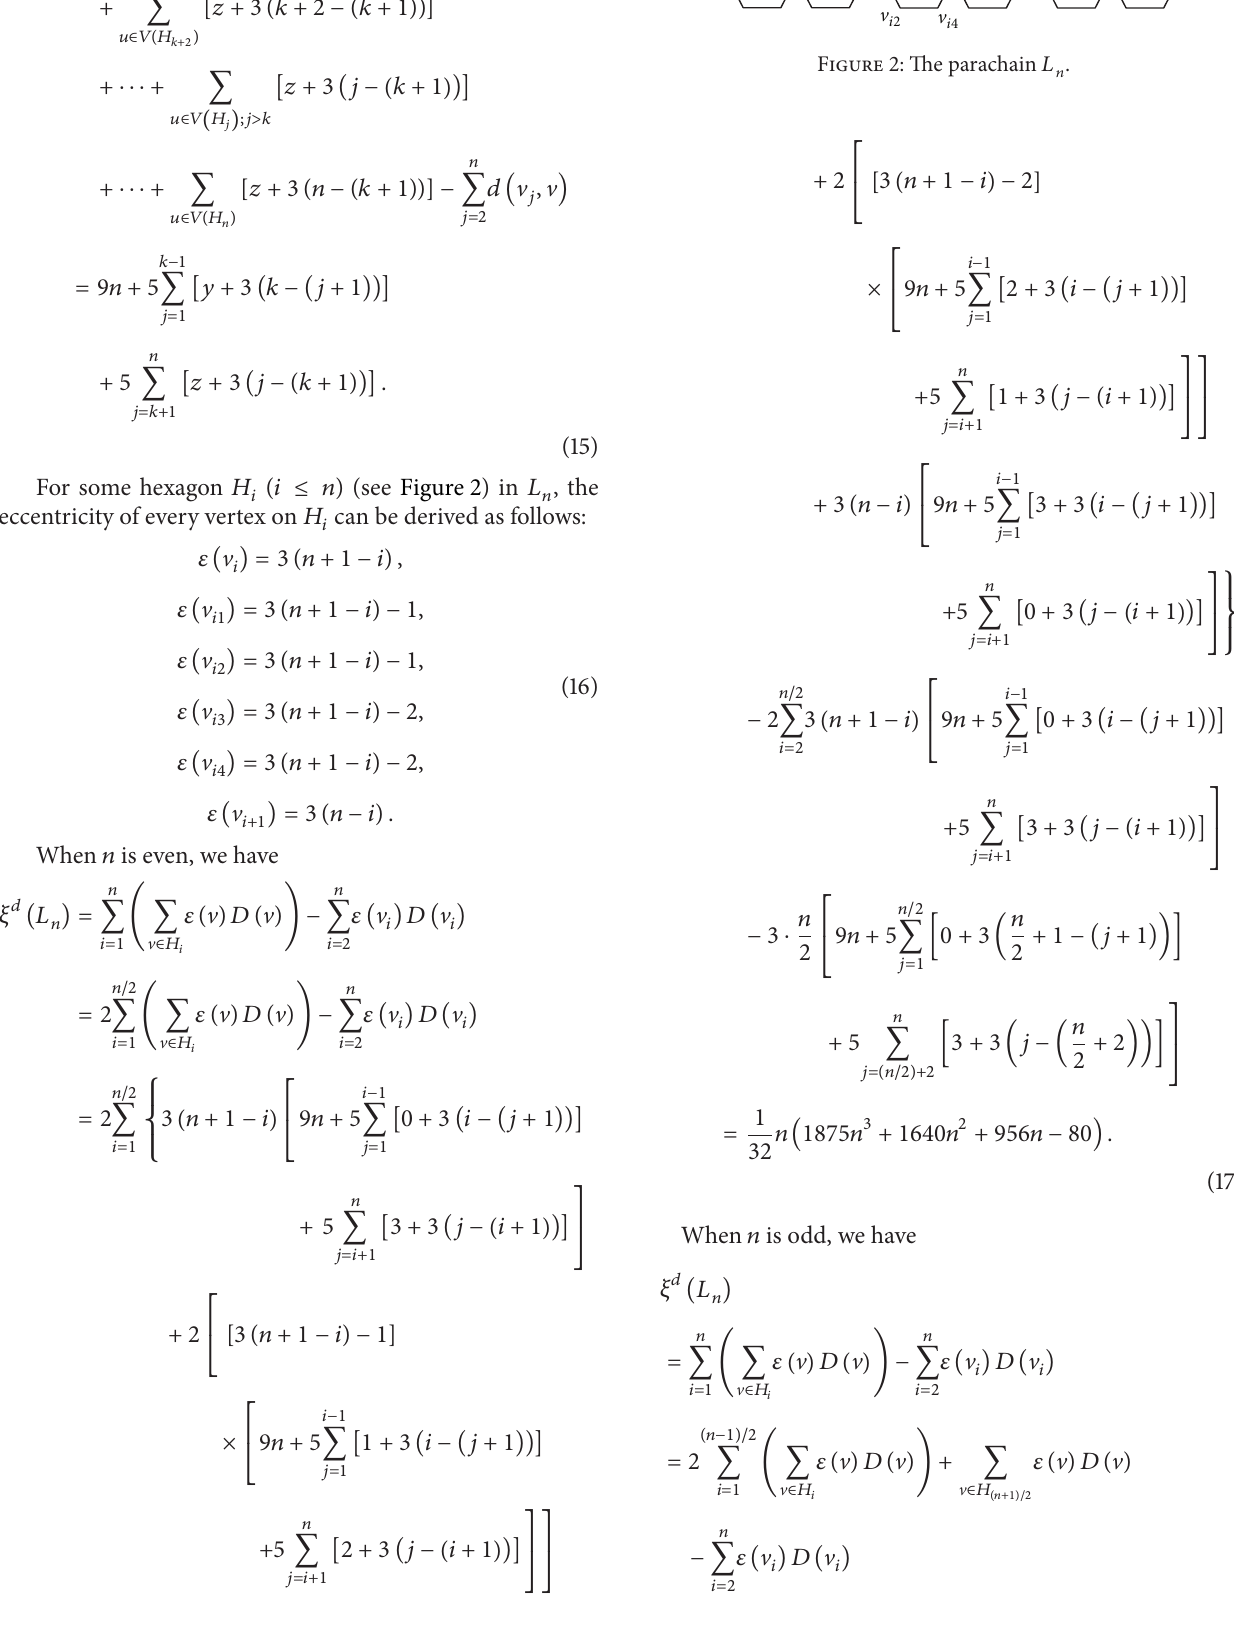
Figure 2: The parachain 𝐿 𝑛